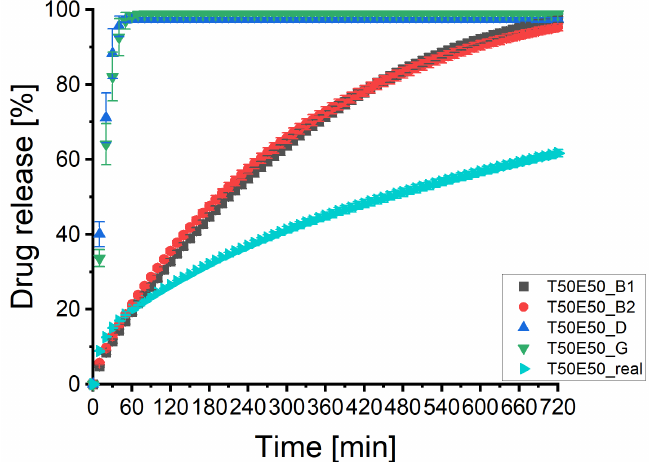
Figure 6. The predicted dissolution profiles of two image processing pathways of the imaged tablets 1, 3, and 5 of batch T50E50 ( ¯ x SD , n = 3). The experimental determined dissolution profile is depicted as well.